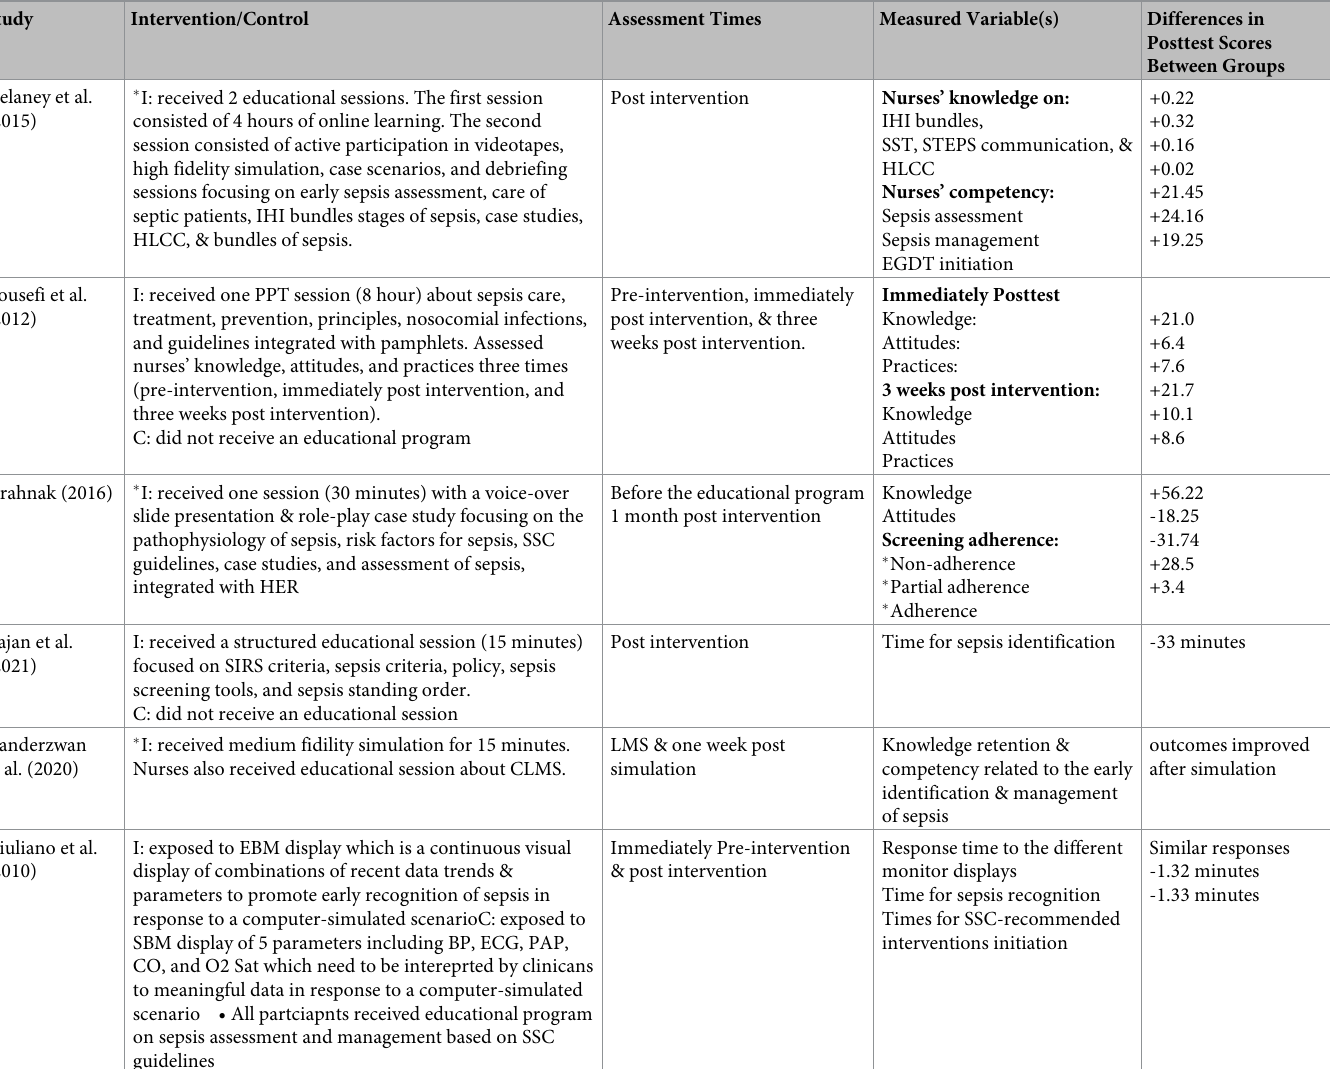
Table 6. Sepsis education programs and